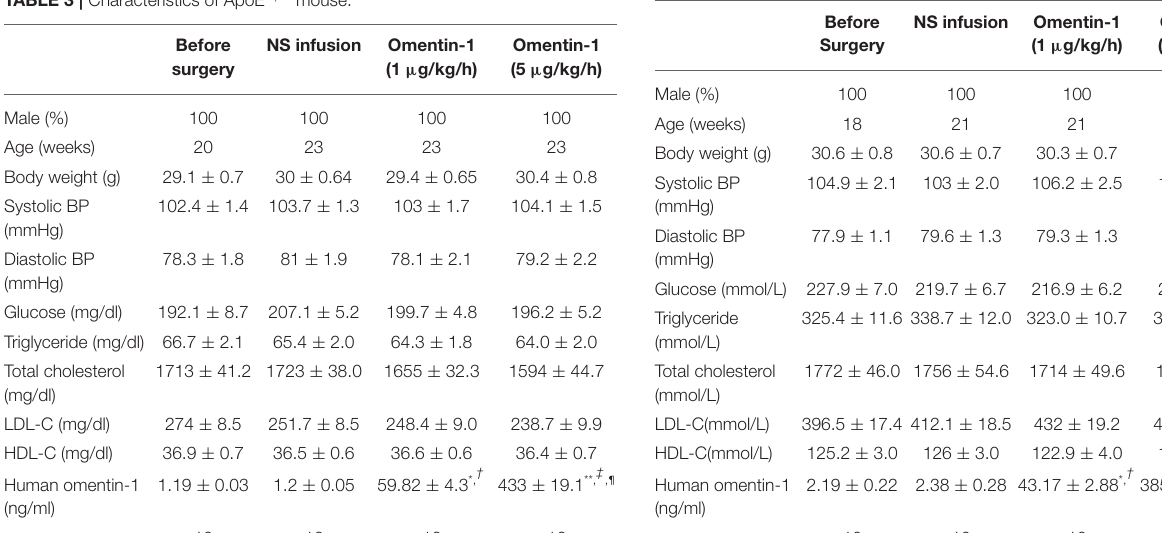
TABLE 4 | Characteristics of Ldlr − / −